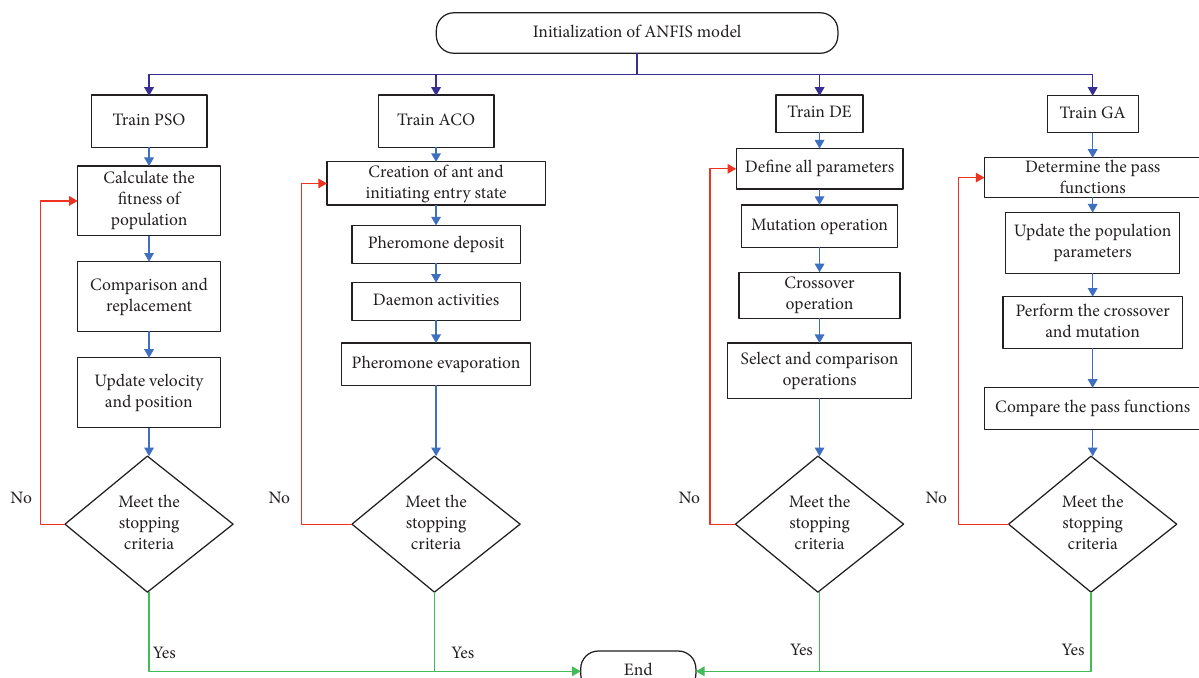
Figure 3: The flow chart of the proposed hybrid ANFIS models; the optimization procedure of each integrated nature inspired